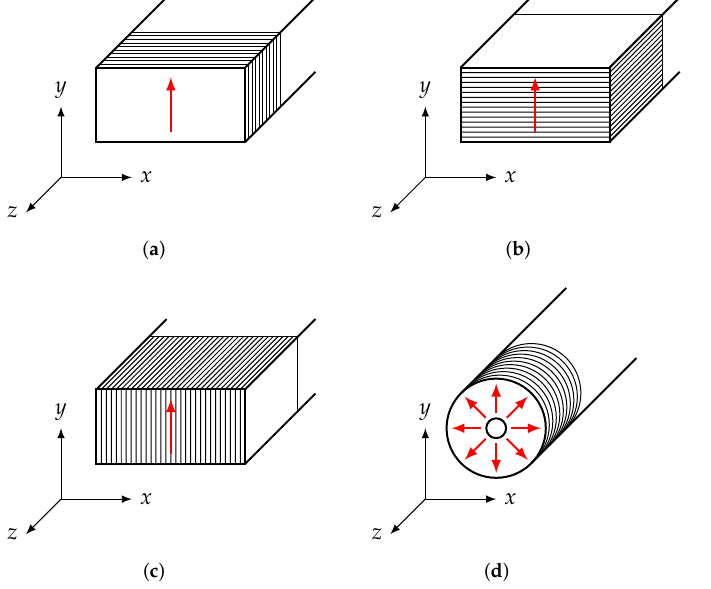
Figure 12. Waveguide and coaxial samples with electric field orientation indicated. ( a ) Waveguide, xy orientation; ( b ) waveguide, xz orientation; ( c ) waveguide, yz orientation; ( d )